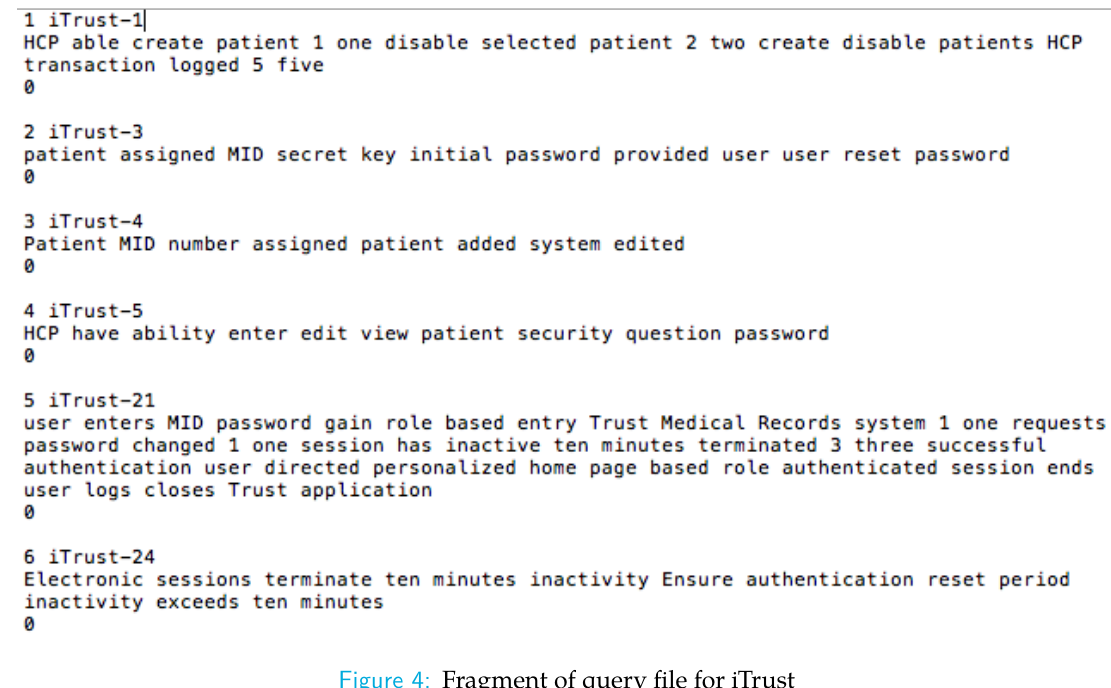
Figure 4: Fragment of query file for